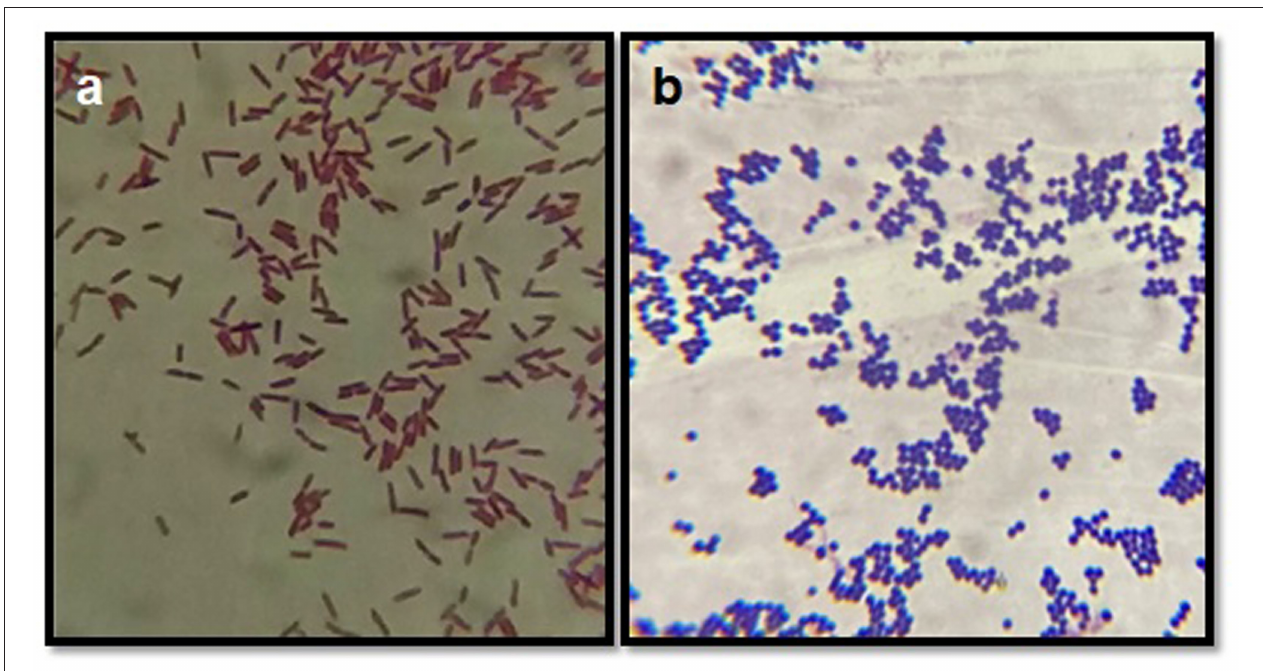
FIGURE 3 | Gram’s staining of bacterial isolates. (a) Depicts the Gram negative rods ( E. coli ) and (b) depicts the Gram positive cocci (bunches) S. aureus